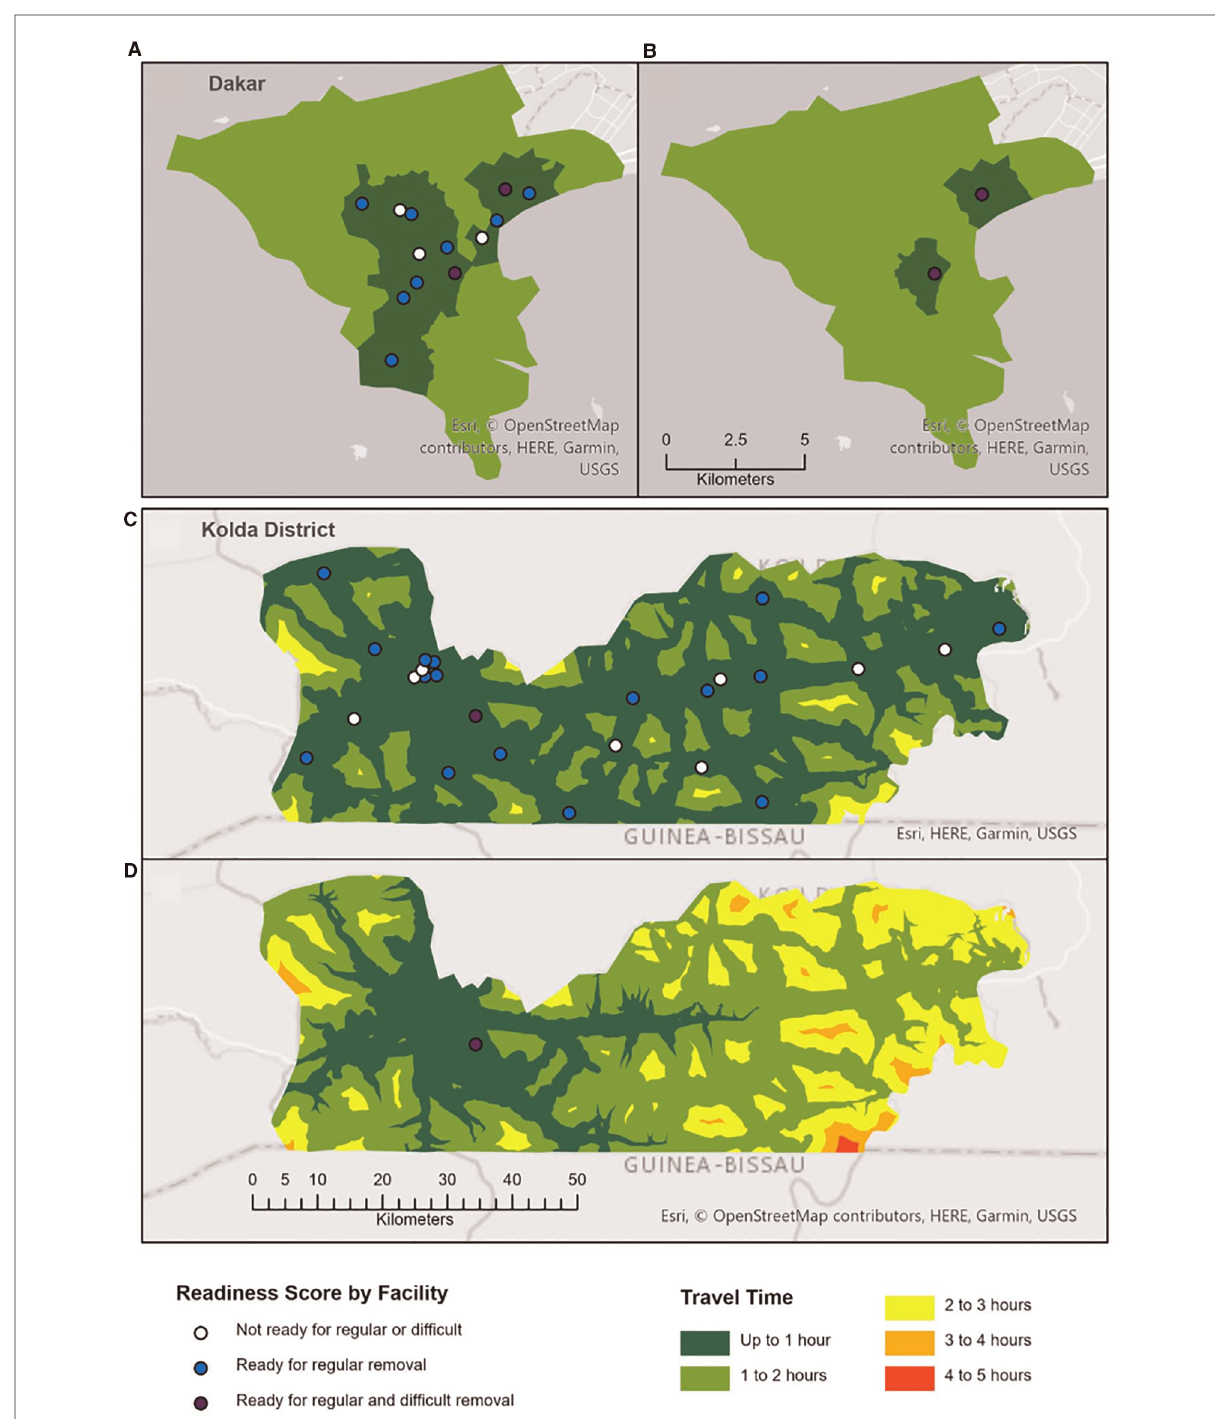
FIGURE 2 Travel time access to removal services. ( A ) Regular removal in Dakar. ( B ) Dif fi cult removal in Dakar. ( C ) Regular removal in Kolda District. ( D ) Dif fi cult removal in Kolda